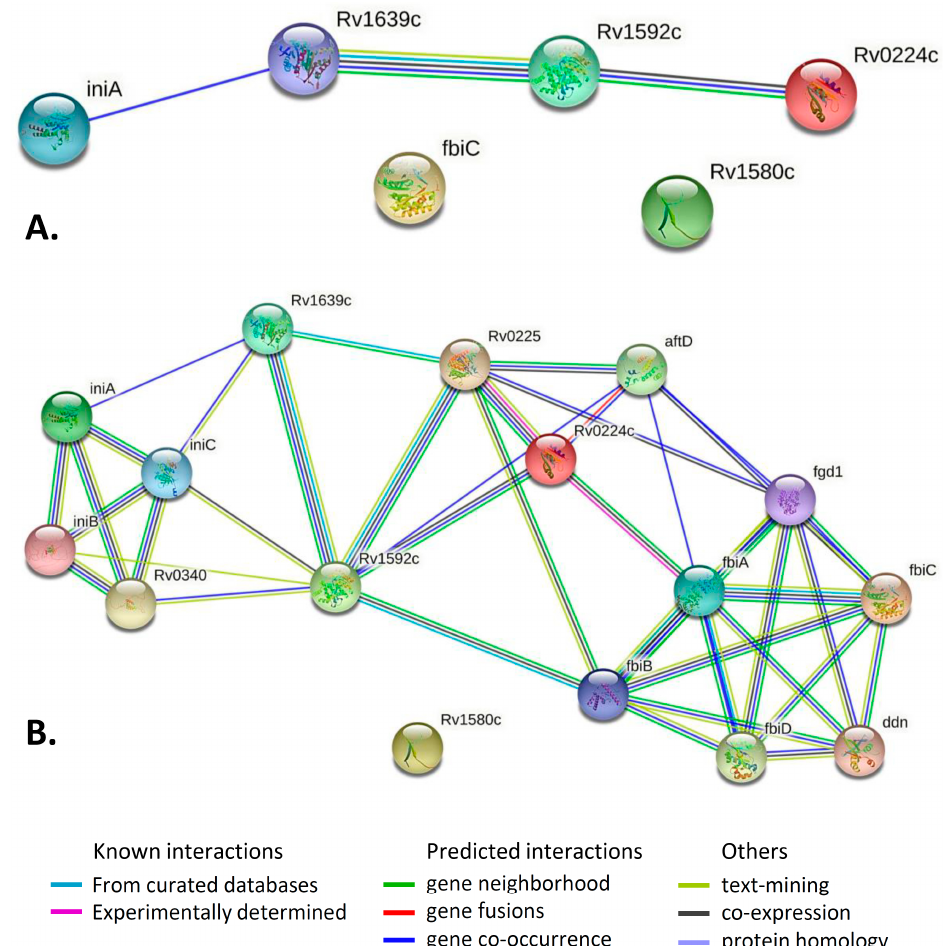
Figure 2. Gene interaction network of ( A ) six studied genes Rv0224c , Rv0342 (iniA) , Rv1173 (fbiC) , Rv1580c , Rv1592c , Rv1639c , and ( B ) six studied genes (marked with v) and 10 added genes. Created using STRING. Minimum required interaction score: 0.150 (low-confidence). Edges represent protein-protein associations.